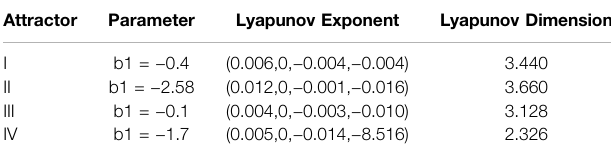
TABLE 1 | LE and LD values with different chaotic